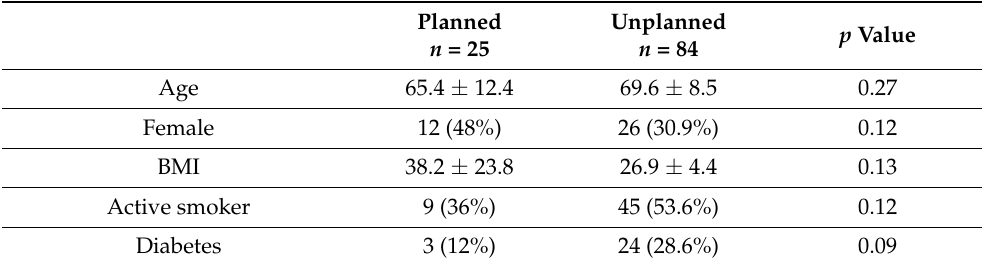
Table 7. Re-explorations in the ICU setting: pre-op and intraoperative